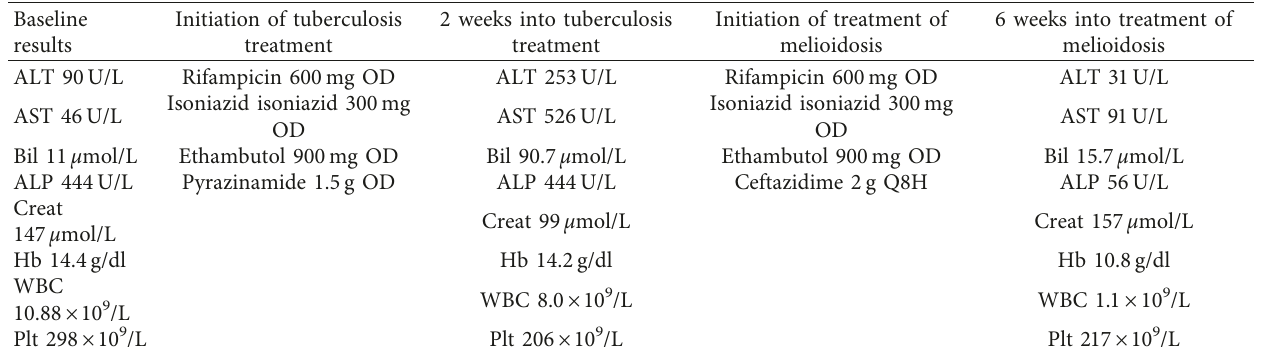
Table 1: Summary of pertinent laboratory investigation results and medications used for treatment of tuberculosis and melioidosis. Baseline